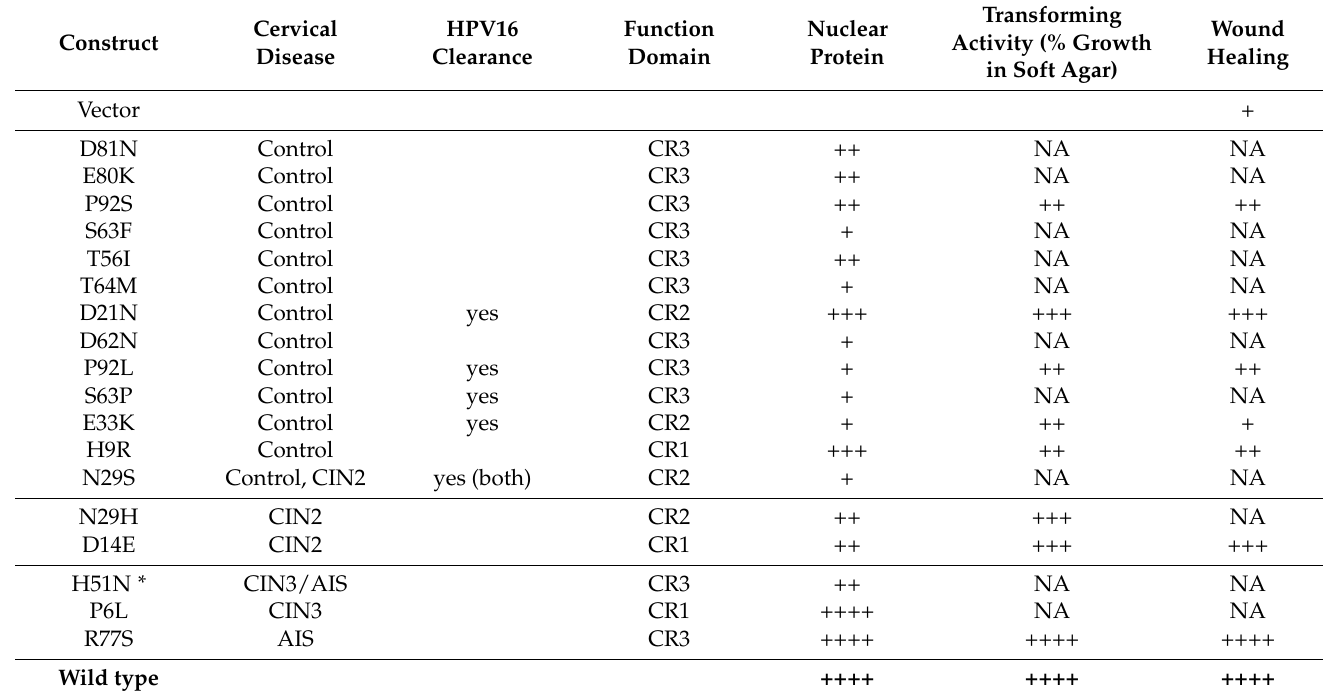
Table 2. Summary of the HPV16 E7 variants, protein expression and functional